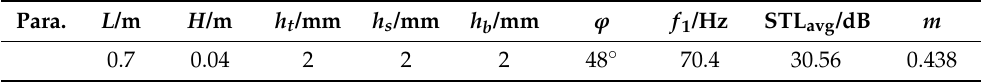
Table 2. Parameters of the baseline model. Para.